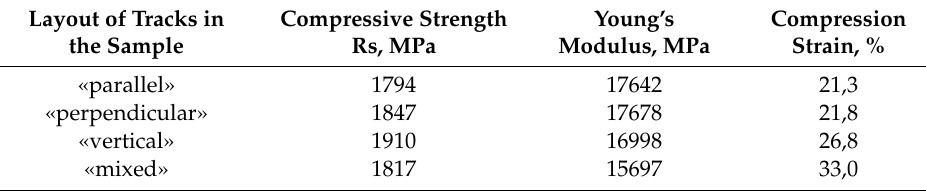
Table 3. Average values of mechanical properties depending on the layout of the